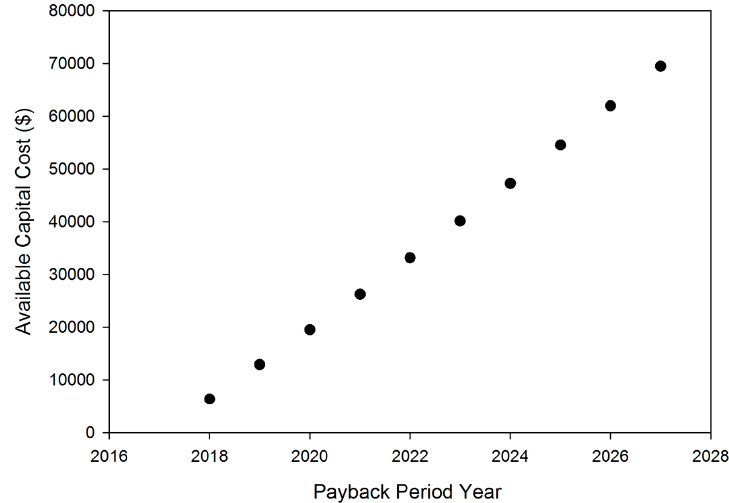
Figure 10. The ACC for a restaurant in Tucson, AZ.